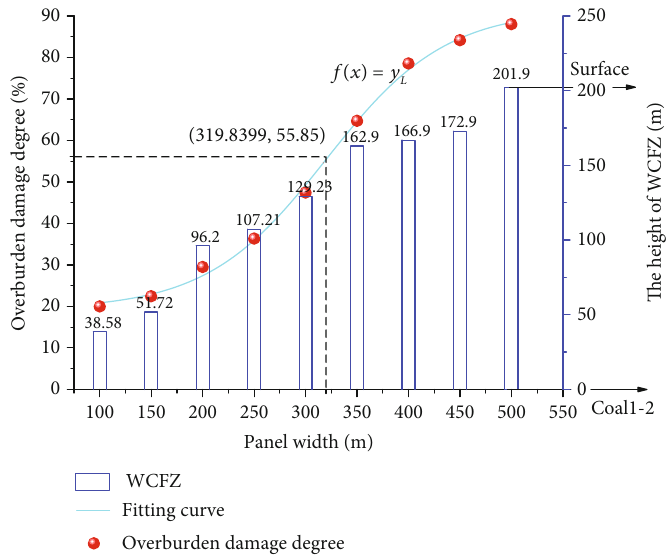
Figure 8: Overburden damage degree and the height of WCFZ versus panel